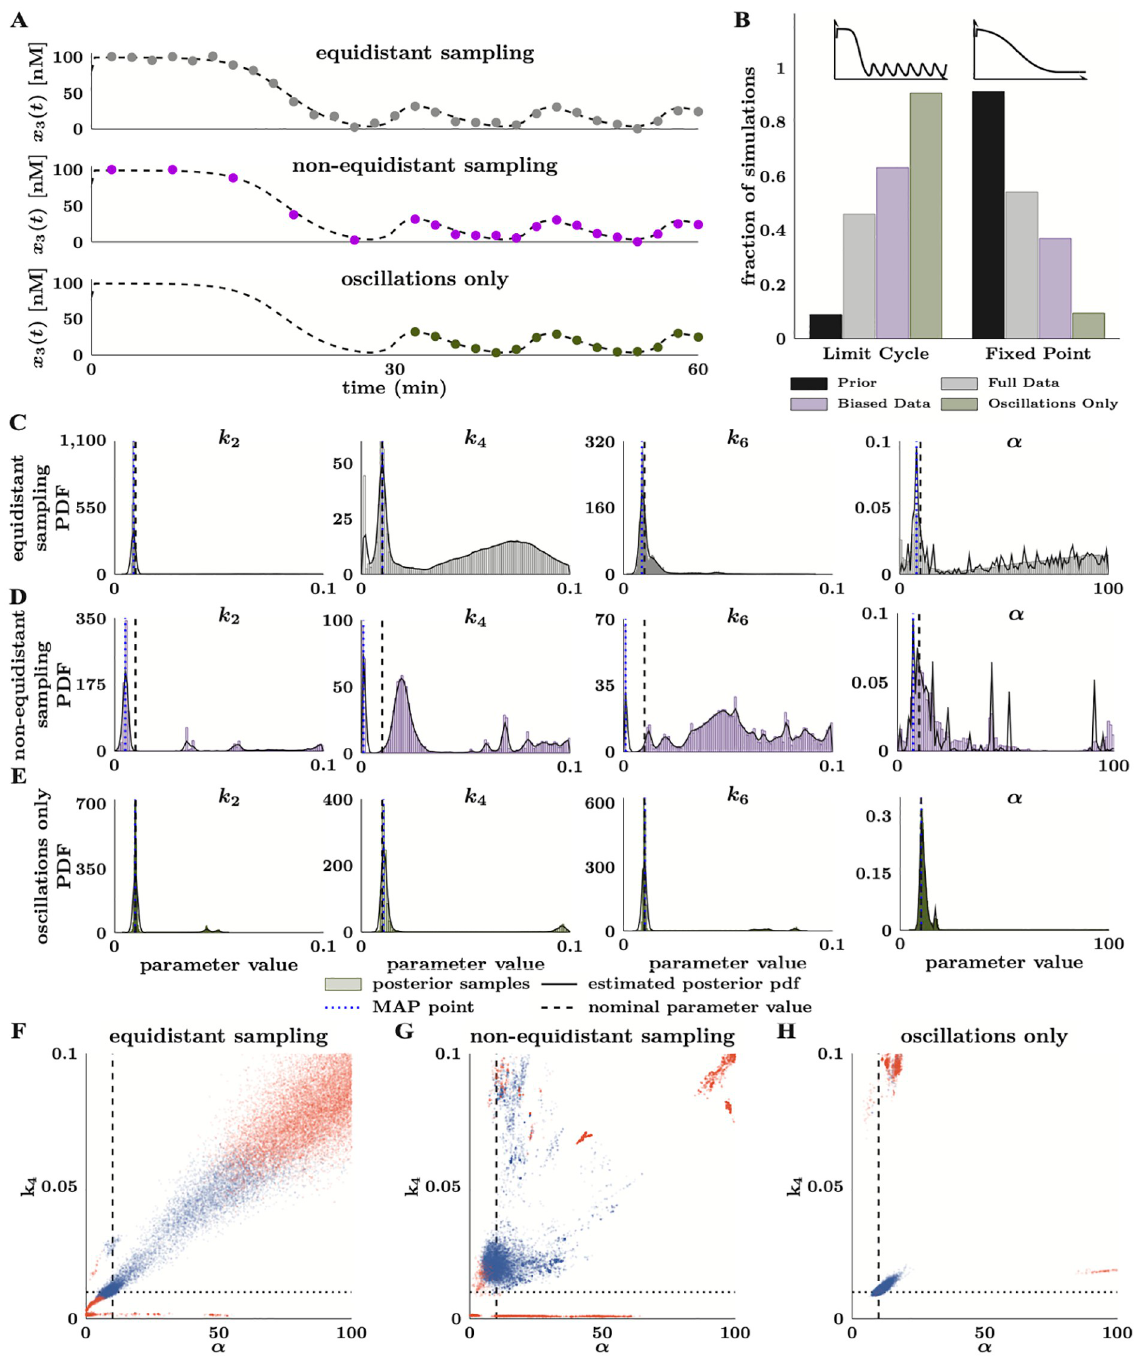
Fig 7. Parameter estimation results for the MAPK model in the limit cycle regime with varied sampling strategies. ( A ) The equidistant sampling data includes 30 samples taken every 2 minutes over 0 < t � 60 (min). The non-equidistant sampling data includes 20 total samples with two sampling rates; there are 5 samples taken every 5 minute for the first 30 minutes and 15 samples taken every 2 minutes for 30 additional minutes. The oscillations only data set only includes samples from the oscillations with 15 samples taken every two minutes over the interval t 2 (30, 60]. ( B ) The fraction of the 30,000 simulations that yield limit cycle or fixed point trajectories, with parameter samples from the prior, and the posterior distribution associated with each data set. ( C – E ) Marginal posterior distributions of the model parameters. Distributions are visualized by fitting a kernel density estimator to 2,524,800 samples for the equidistant sampling data, 763,080 for the non- equidistant sampling data, and 1,305,720 for the oscillations only data. ( F – H ) Two-dimensional scatter plots reveal relationships between k 4 and α that are necessary to produce limit oscillations. Simulations with blue points produce limit cycle oscillations, and those with red points produce fixed points. Darker regions indicate a higher probability of observing the corresponding parameter